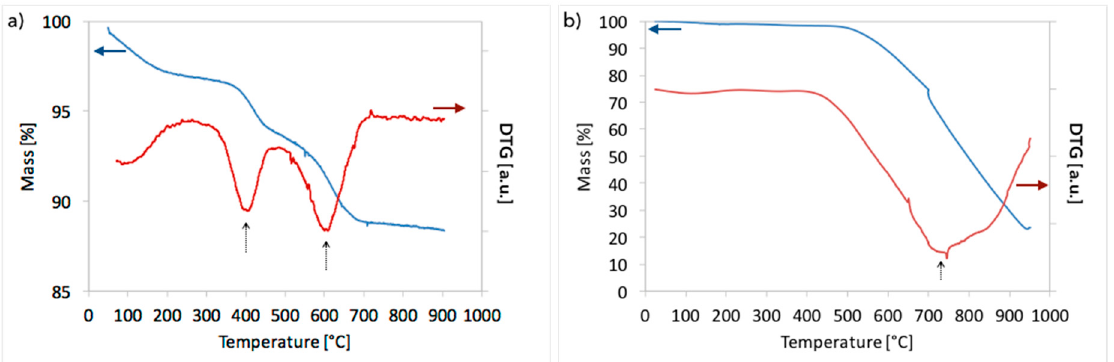
Figure 7. TGA for ( a ) Ni/CeZrO 2 and ( b ) Ni-MgO catalyst after CH 4 decomposition (T = 700 °C; 10 vol.% CH 4 /Ar; GHSV = 7000 h − 1 ; t = 1 h).